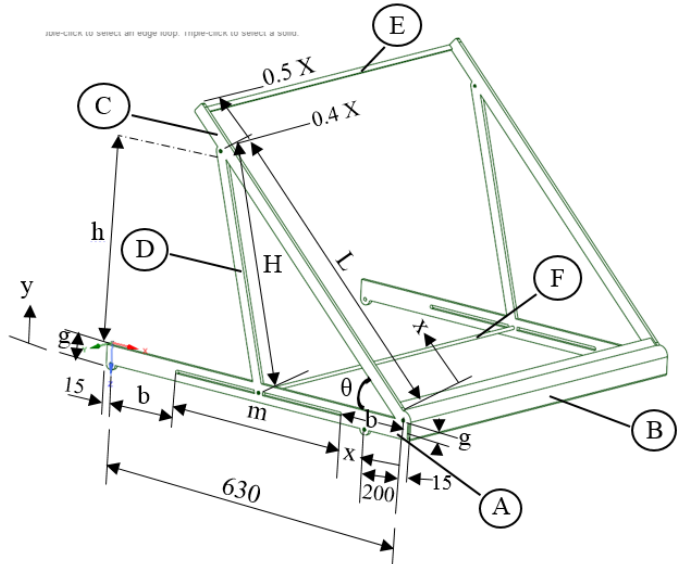
Figure 5. The assembly drawing of the proposed solar photovoltaic tilting platform